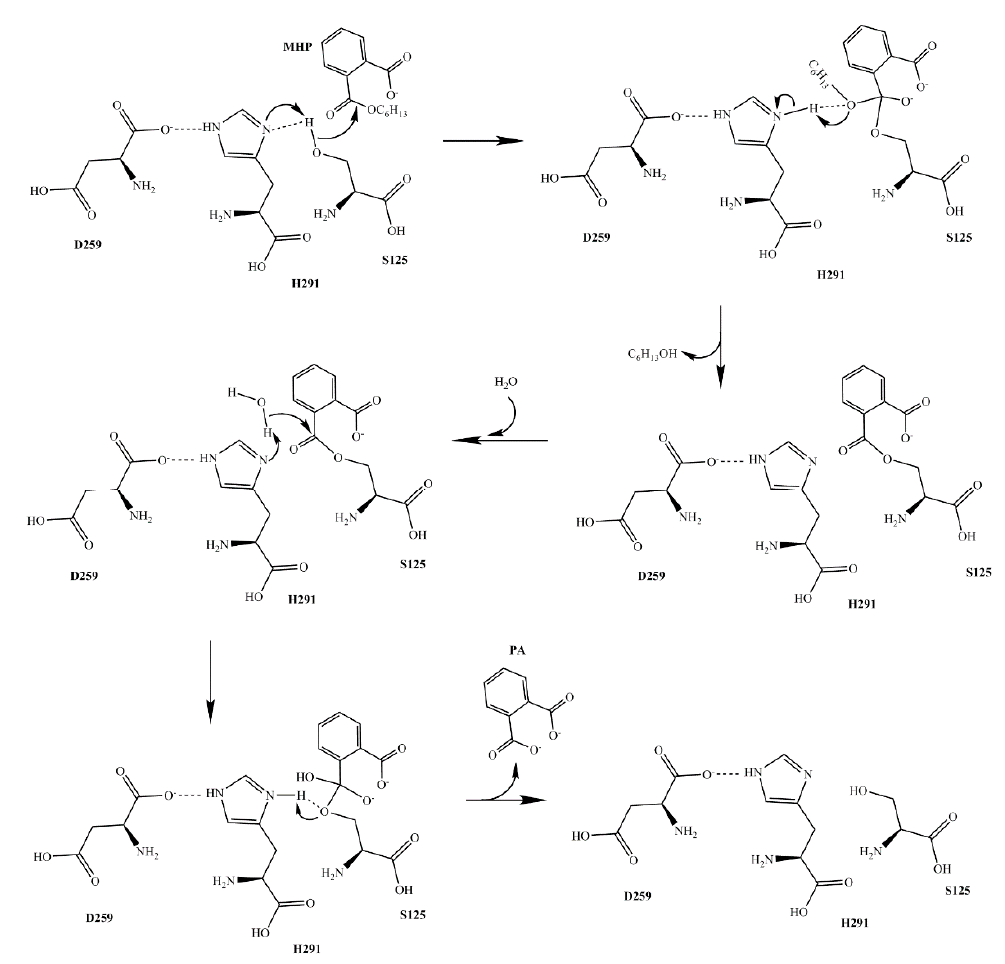
Figure 8. The proposed catalytic mechanism of MphG1.